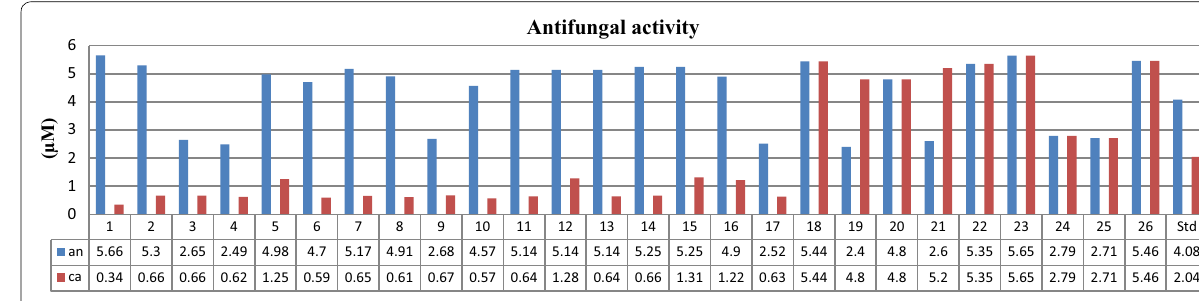
Fig. 4 Antifungal screening results against fungal species